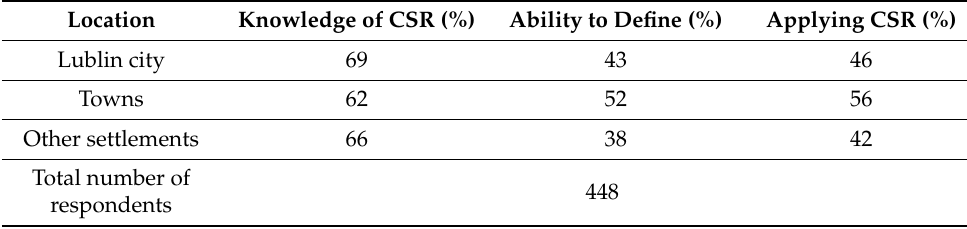
Table 2. CSR knowledge, ability to define and apply (% of respondents). Location Knowledge of CSR (%) Ability to Define (%) Applying CSR (%) Lublin city 69 43 46 Towns 62 52 56 Other settlements 66 Total number